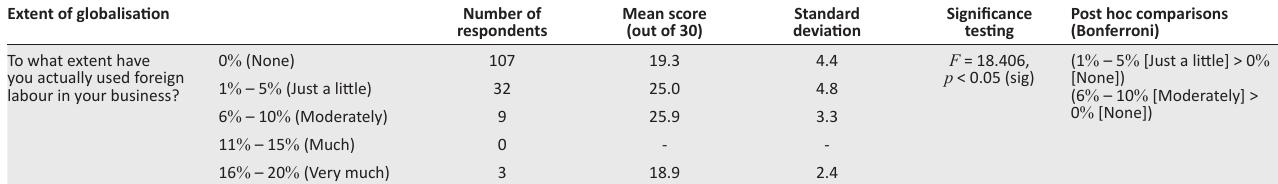
TABLE 10: Comparison of mean scores on the ‘long-term performance expectations’ index by extent of internationalisation. Extent of